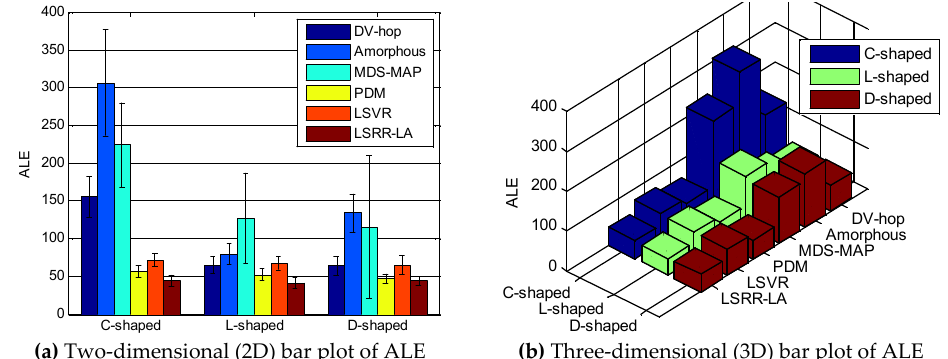
Figure 6. The ALE results of C-shaped random networks.